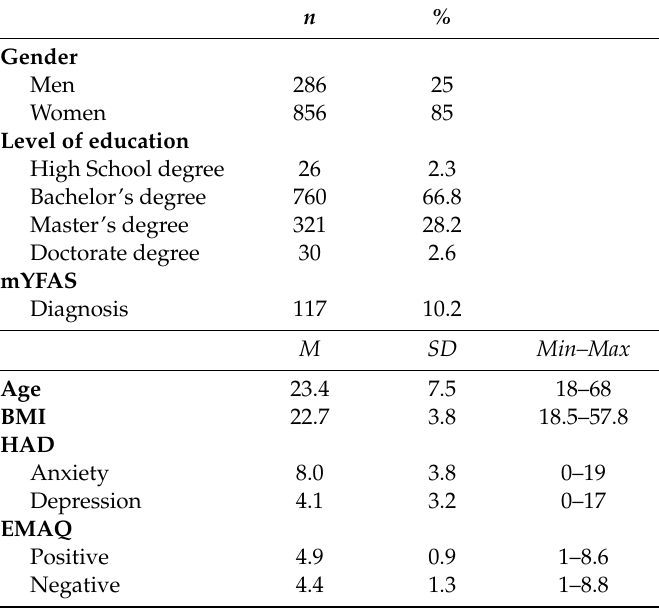
Table 1. Descriptive statistics of the